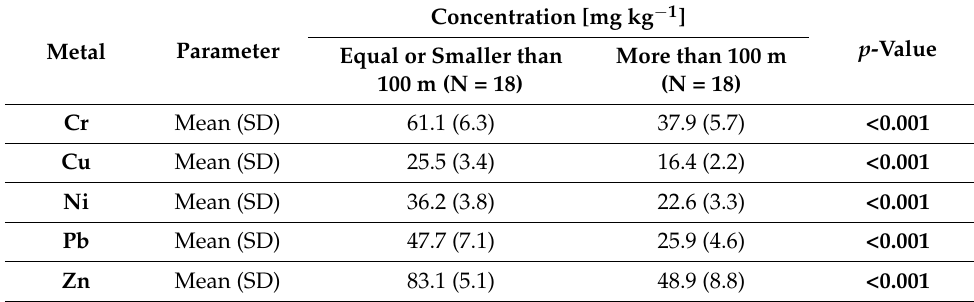
Table 4. Comparison of elements from the open area against distance.